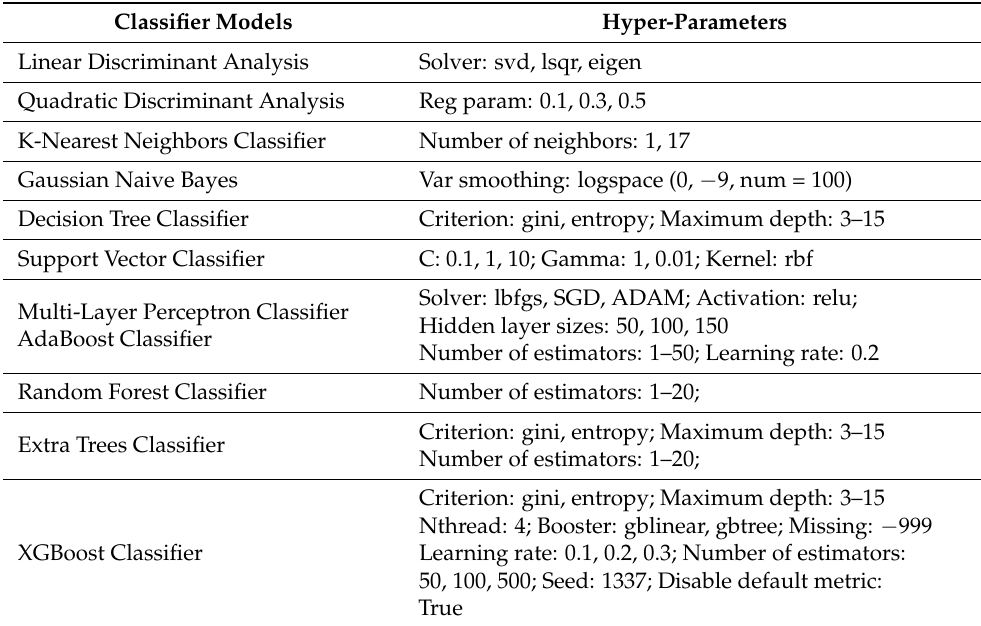
Table 5. The table shown the configuration for the exhaustive search of the best parameter in each classifier model. The best parameter is implemented to obtain the best «scoring